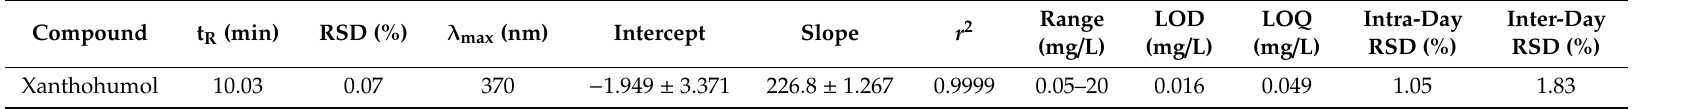
Table 4. Retention time, precision, linearity and sensitivity parameters of the HPLC-diode array detector (DAD) method for XN analysis.